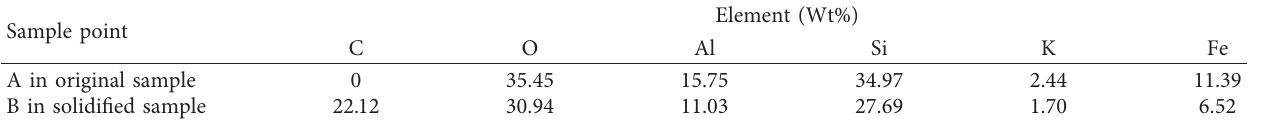
Figure 5: Micromorphology and energy spectrum of the original red clay (a) and red clay reinforced with ISS (b). Table 11: Elemental analysis of red clay before and after reinforcement with